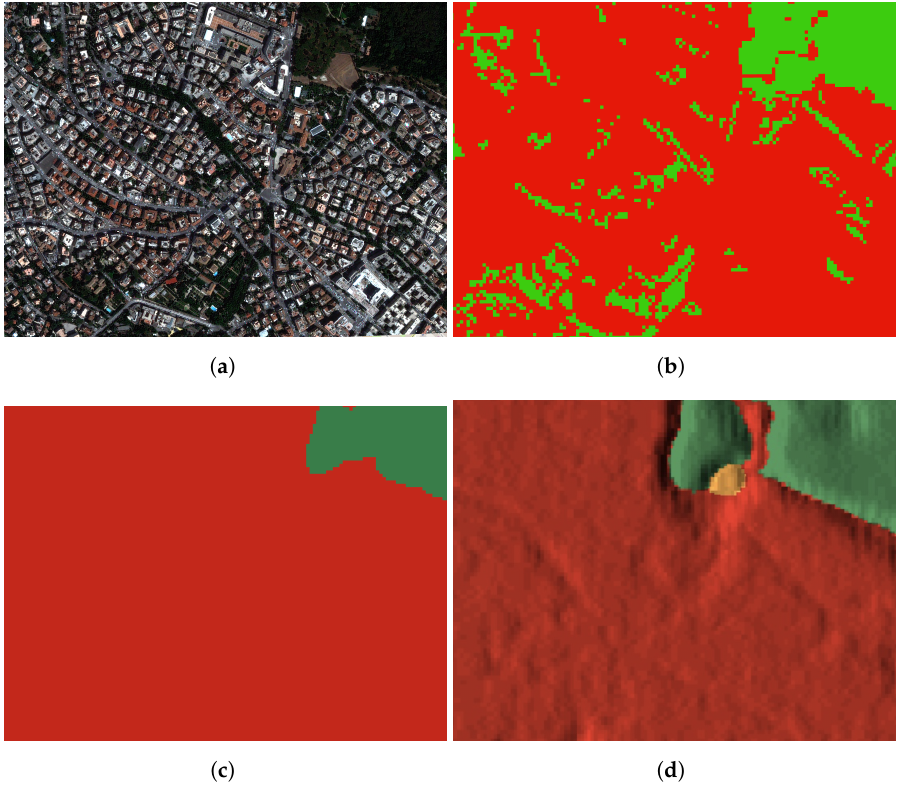
Figure 1. High-resolution Pleiades satellite image of a dense urban area in Rome, Italy ( a ), and the corresponding imperviousness maps from ISPRA ( b ), ESRI ( c ) and DynamicWorld ( d ). For impervi- ousness maps, red indicates impervious areas while green corresponds to non-impervious